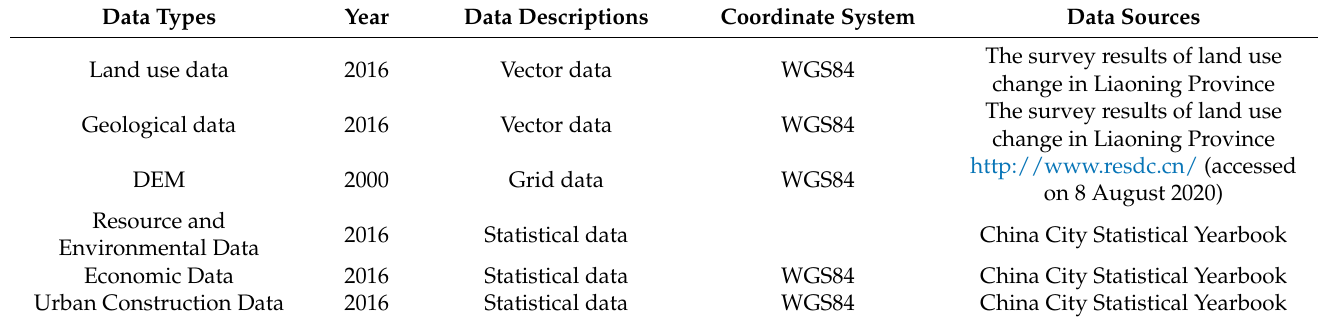
Table 1. Data source and